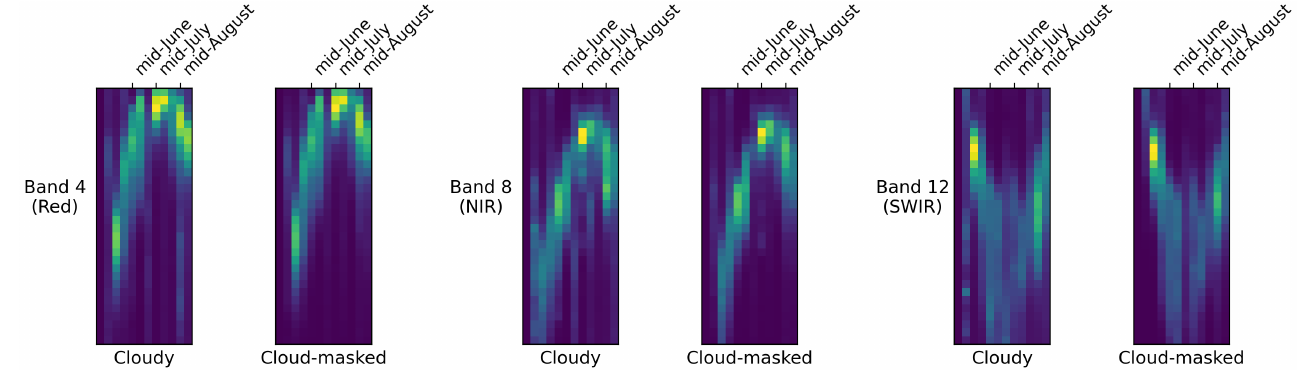
Figure 7. Histograms of three Sentinel-2 bands from spring wheat fields of a farm as 11-day compos- ites. Calculated from cloudy and cloud-masked surface reflectance.